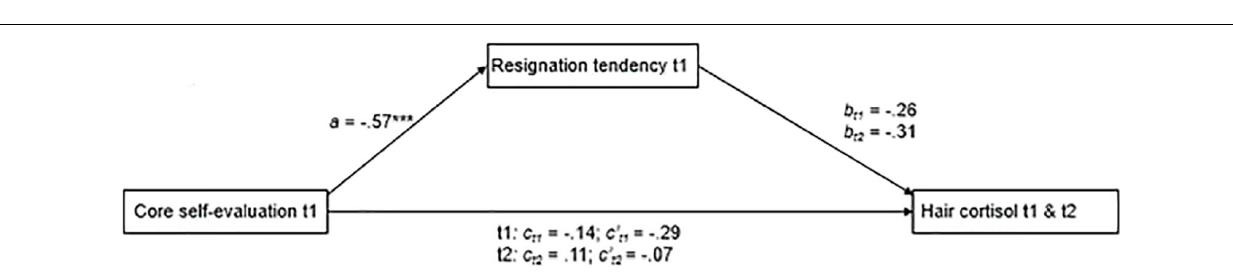
FIGURE 1 | Results of the path-analytical model testing indirect effects of core self-evaluation over resignation tendency on vital exhaustion t1 ( N = 42) and t2, accounting for vital exhaustion t1 ( N = 39). To simplify the presentation, we standardized the coefficients and omitted error terms and effects of control variables.